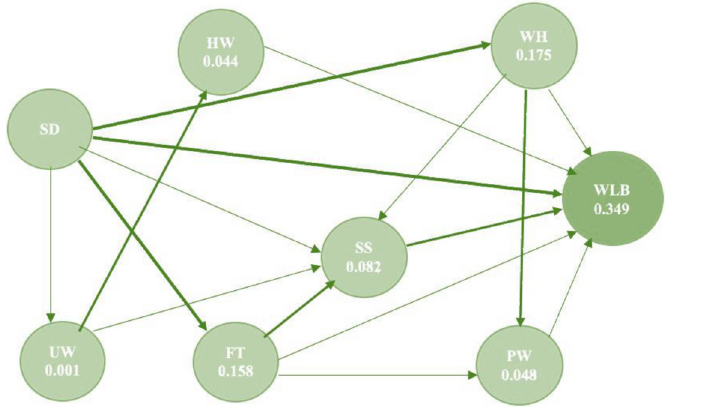
Figure 1. Decent work and WLB